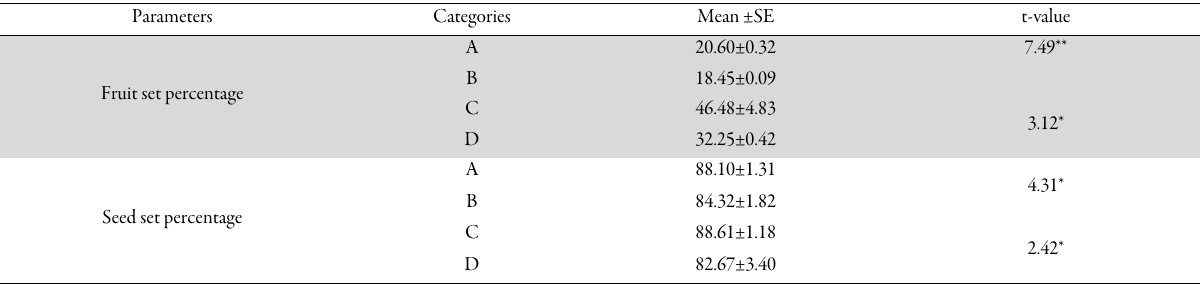
Table 3. Mean comparison by t-test of the fruit set and seed set percentages among the various pollination methods Parameters Categories t-value